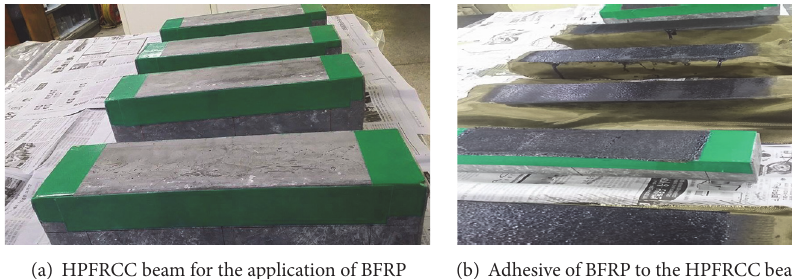
Figure 6: Ready-to-laminate and laminated beam with basalt